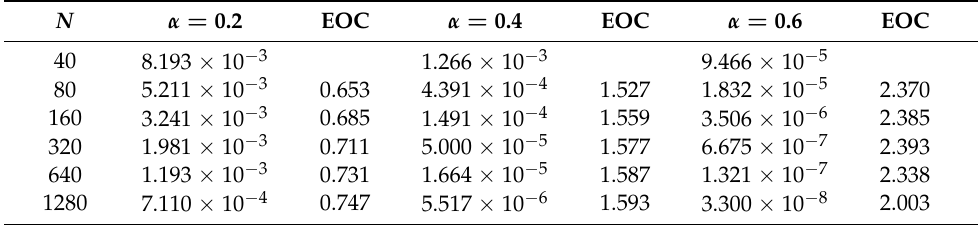
Table 10. Table showing the maximum absolute error and EOC for solving (27) using the trapezoidal method on a graded mesh.